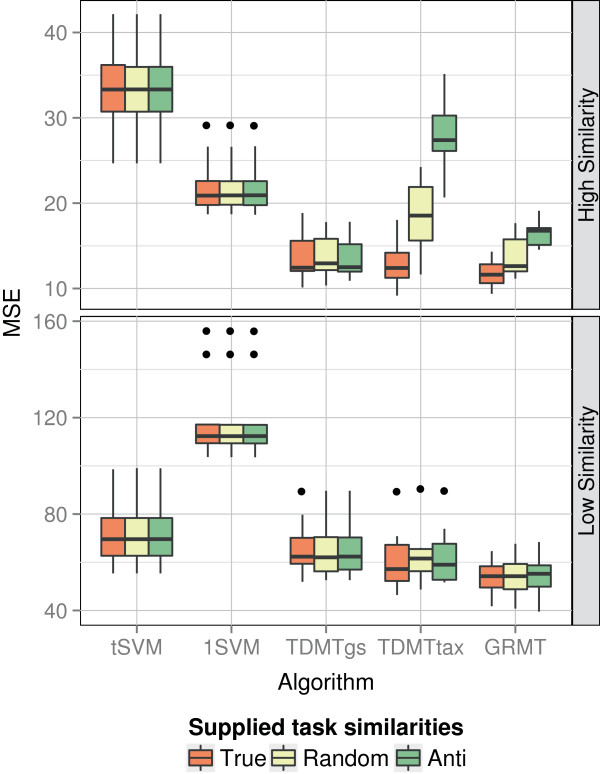
Performance varying the supplied similarities. Mean squared error (MSE)
while varying the supplied similarities. Each boxplot visualizes the
performance on the 10 randomly generated test splits. True stands for correct
task similarities given by kcos,
Anti for anti correlated similarities given by
1−kcos, and Random
for random similarities. The upper graph shows results for a high task
similarity between the simulated tasks, the lower graph for a low
similarity.